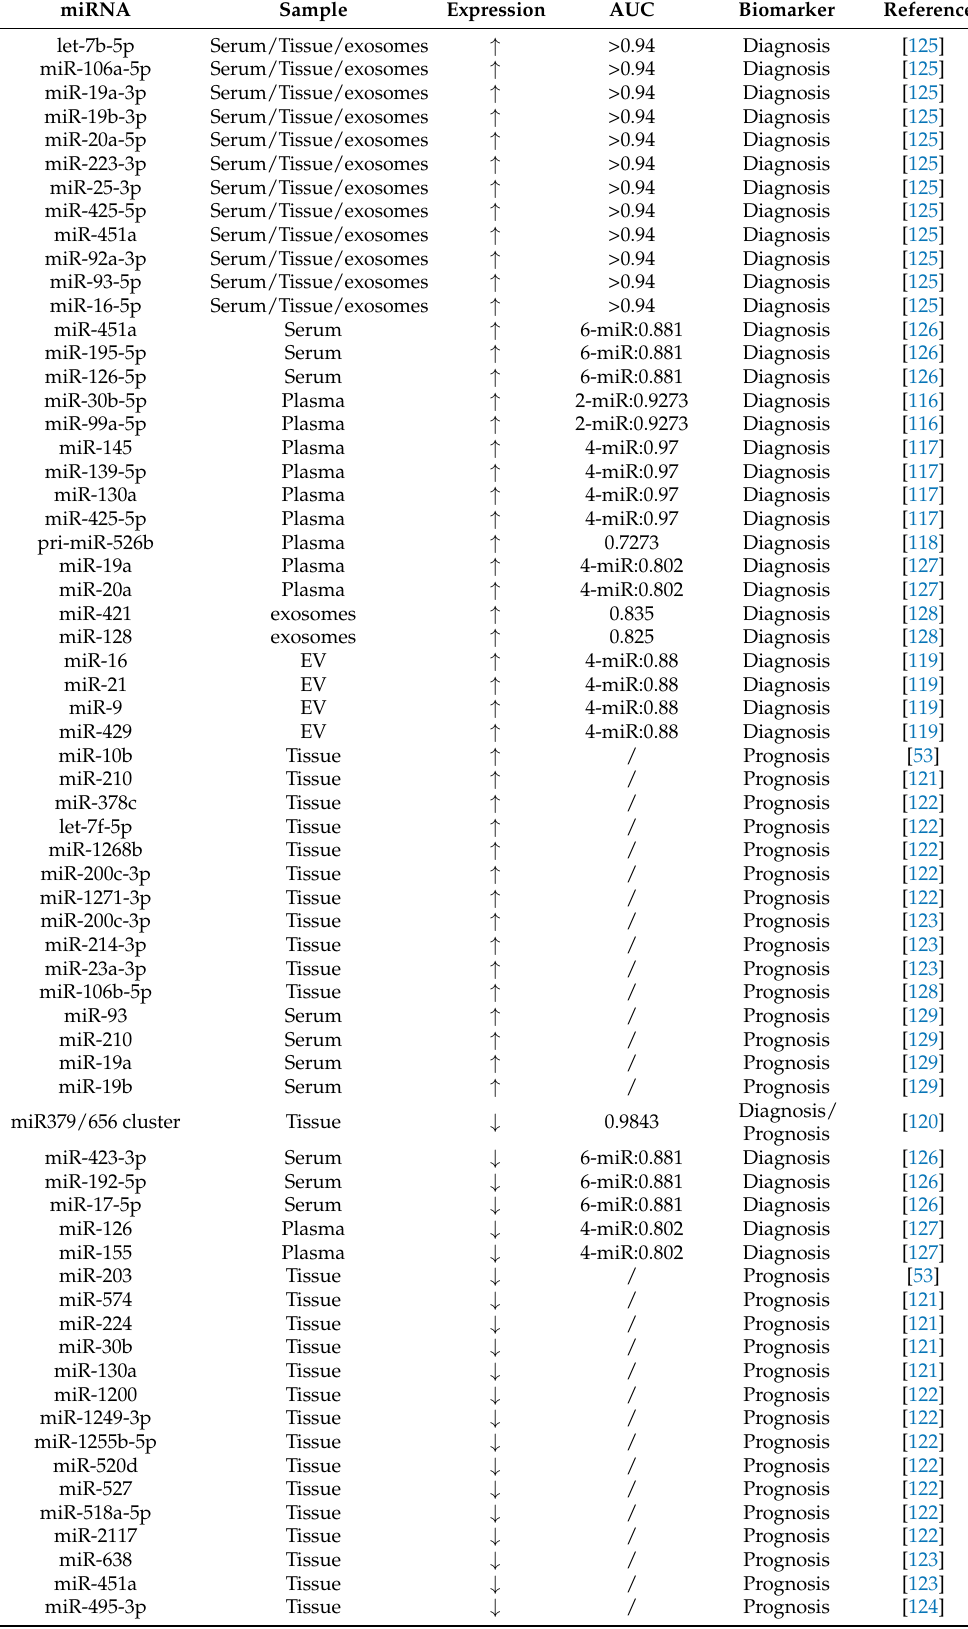
Table 5. MicroRNAs as biomarkers for diagnosis and prognosis of BC.